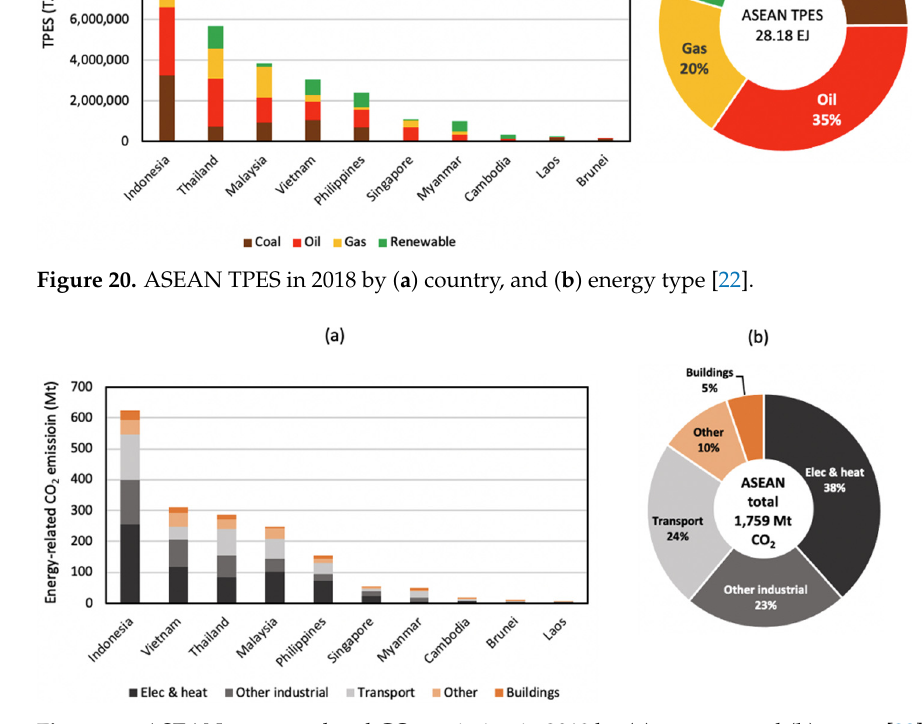
Figure 21 . ASEAN energy-related CO 2 emission in 2019 by ( a ) country, and ( b ) sector [22] . Figure 21. ASEAN energy-related CO 2 emission in 2019 by ( a ) country, and ( b ) sector